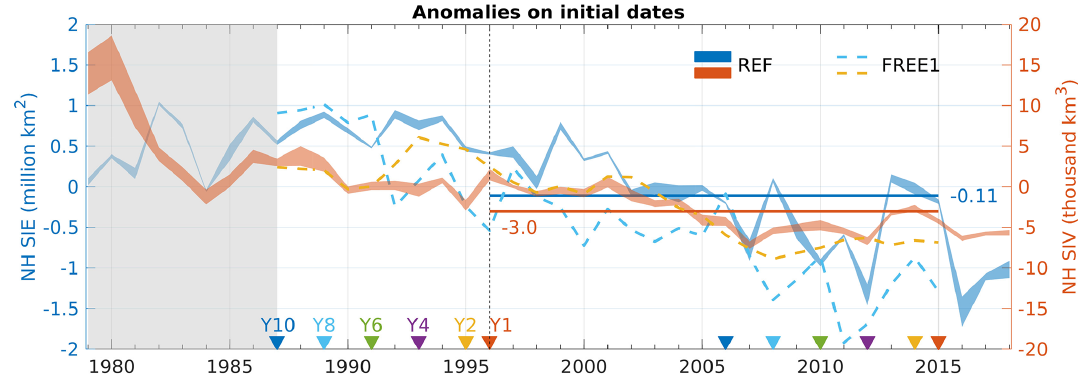
Figure 3. Anomalies of SIC (SIT) on 1 November aggregated for the NH sea ice extent (volume) in blue (red) during 1979–2018. The ensemble spread (between min and max) of REF is presented by filled area, while anomalies of FREE1 are presented by dashed lines. For AI2, the 20-year averages of anomalies taken from REF for lead year 1 (Y1, between two red triangles) are − 0 . 11millionkm 2 for SIE and − 3000km 3 for SIV (straight red and blue lines), respectively. Note that the skill assessment period is from 1997 to 2016 (see Table 2), where Y1 denotes forecast initialized from 1996 to 2015 and Y10 denotes the 10th-year forecast initialized from 1987 to 2006. Thus, the anomalies are more positive for predictions with longer lead years assessed, as can be seen when compared to those in